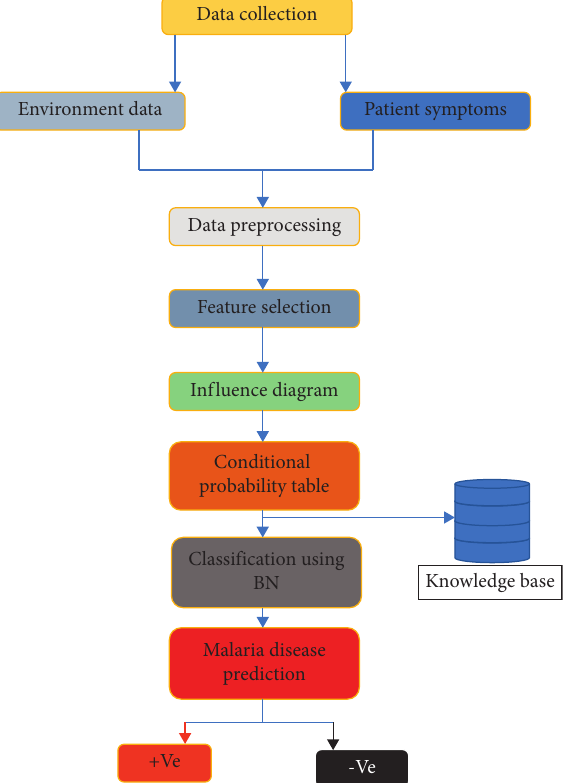
Figure 1: A proposed framework for malaria disease